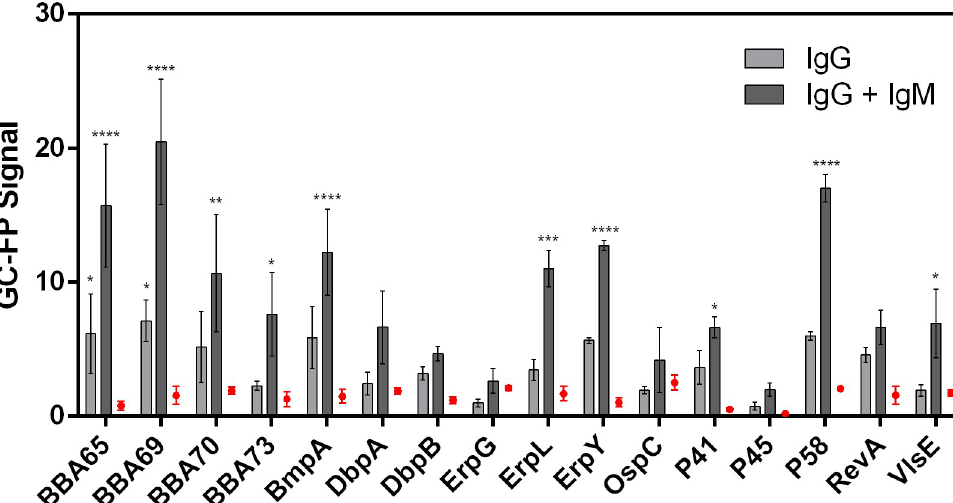
Fig 5. Detection of specific IgG and IgM antibodies in early LD. GC-FP was used to evaluate serum from a patient with early LD but a false-negative result based on the STTT. The mean GC-FP signal ± Standard Error of the Mean for IgG detection and additional IgM detection is plotted for 16 antigen targets. IgG against 2 out of 16 targets were detected with significantly higher signal than the negative control: BBA65, BBA69. Additional detection of IgM antibodies led to amplified signal for those two targets and 8 more targets: P58, BmpA, P41, ErpL, VlsE, ErpY, BBA70, and BBA73, or a total of 10 out of 16 detected targets ( ���� , p < 0.0001; ��� , p < 0.001; �� , p < 0.01; � , p < 0.05; 2-way ANOVA followed by Fisher’s LSD test for multiple